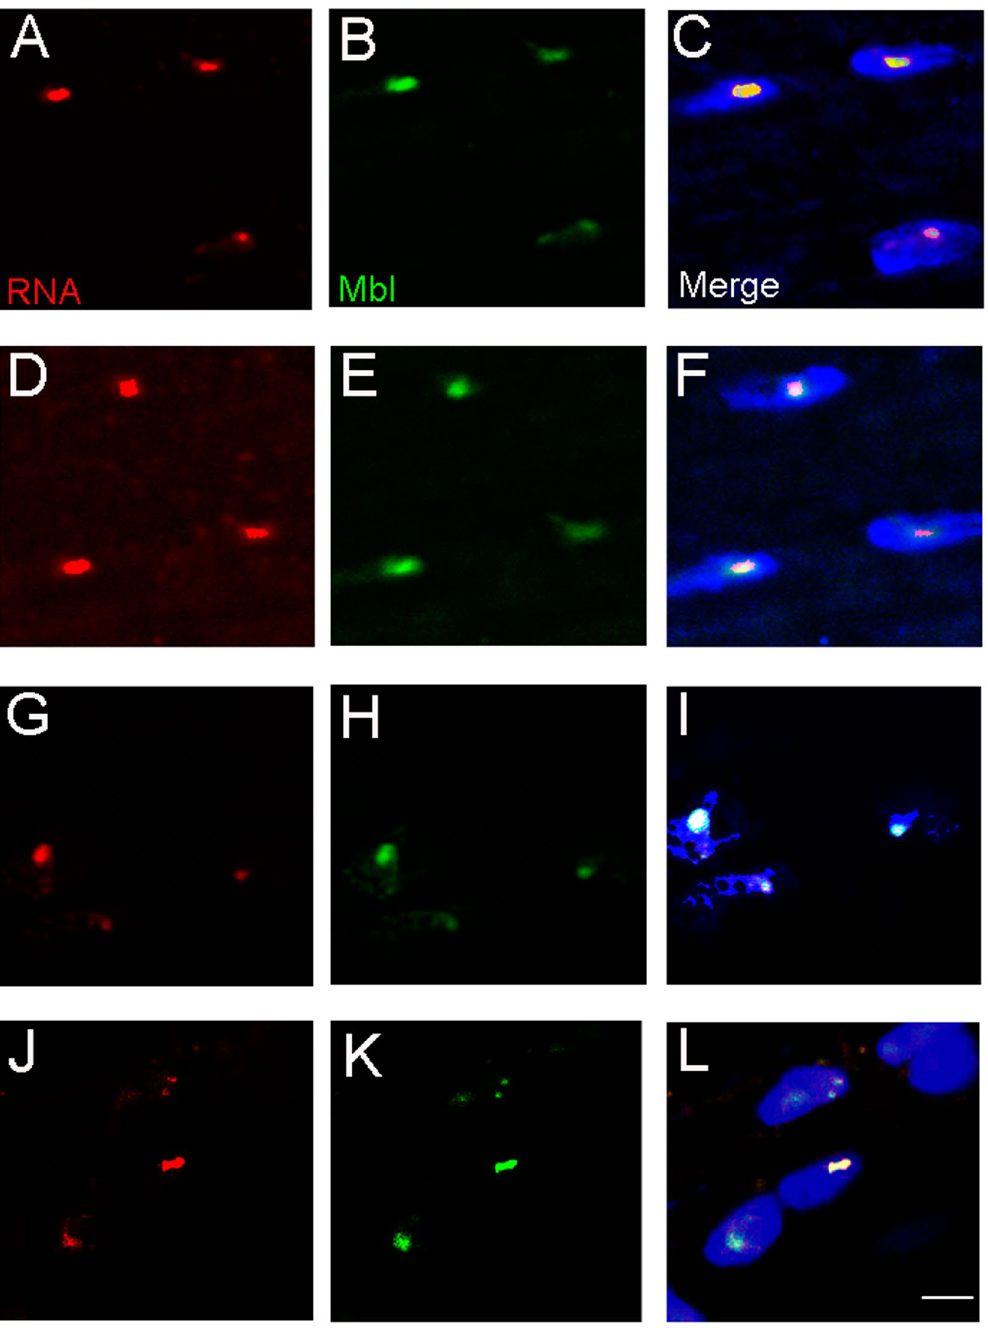
Figure 1. Muscleblind is retained in ribonuclear foci in flies expressing expanded CUG or CCUG repeats. Representative fluorescent confocal images of IFMs ( A – F ) and heart cells ( G – L ) from flies expressing expanded CUG ( A – C and G – I ) or CCUG ( D – F and J – L ) repeats under the control of the Mhc-Gal4 and GMH5-Gal drivers, respectively. Ribonuclear foci retaining Muscleblind were present in flies expressing long CUG or CCUG repeats. Merged images in ( C , F , I and L ) include DAPI (blue) counterstaining of the nuclei. Scale bar = 10 µ